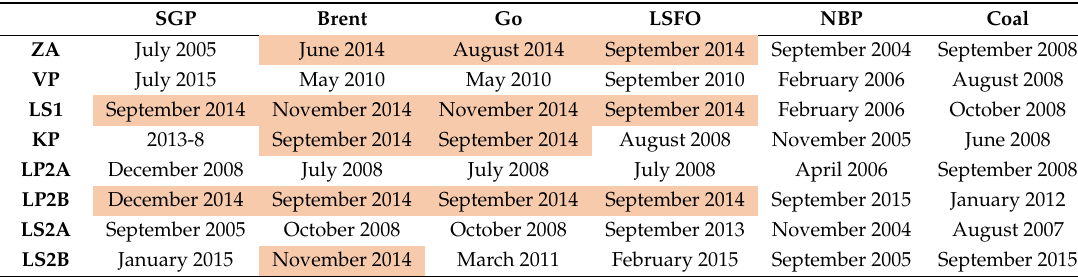
Table 6. Break dates mixed